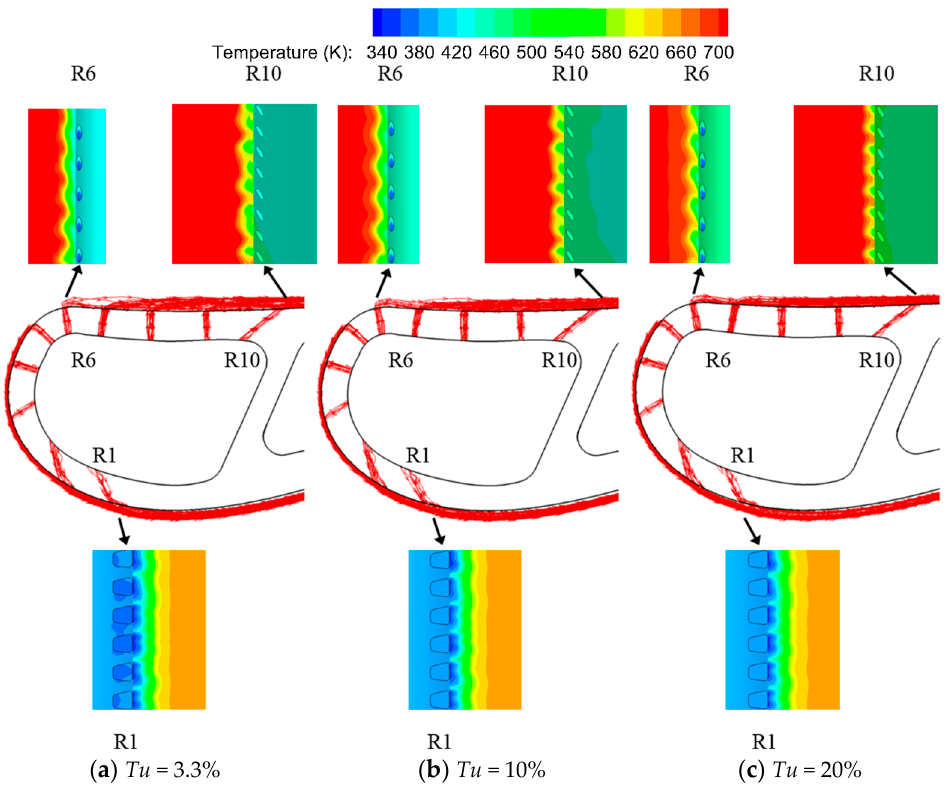
Figure 14. Effect of Tu on streamtraces of cooling air emitted from the film holes at midspan.